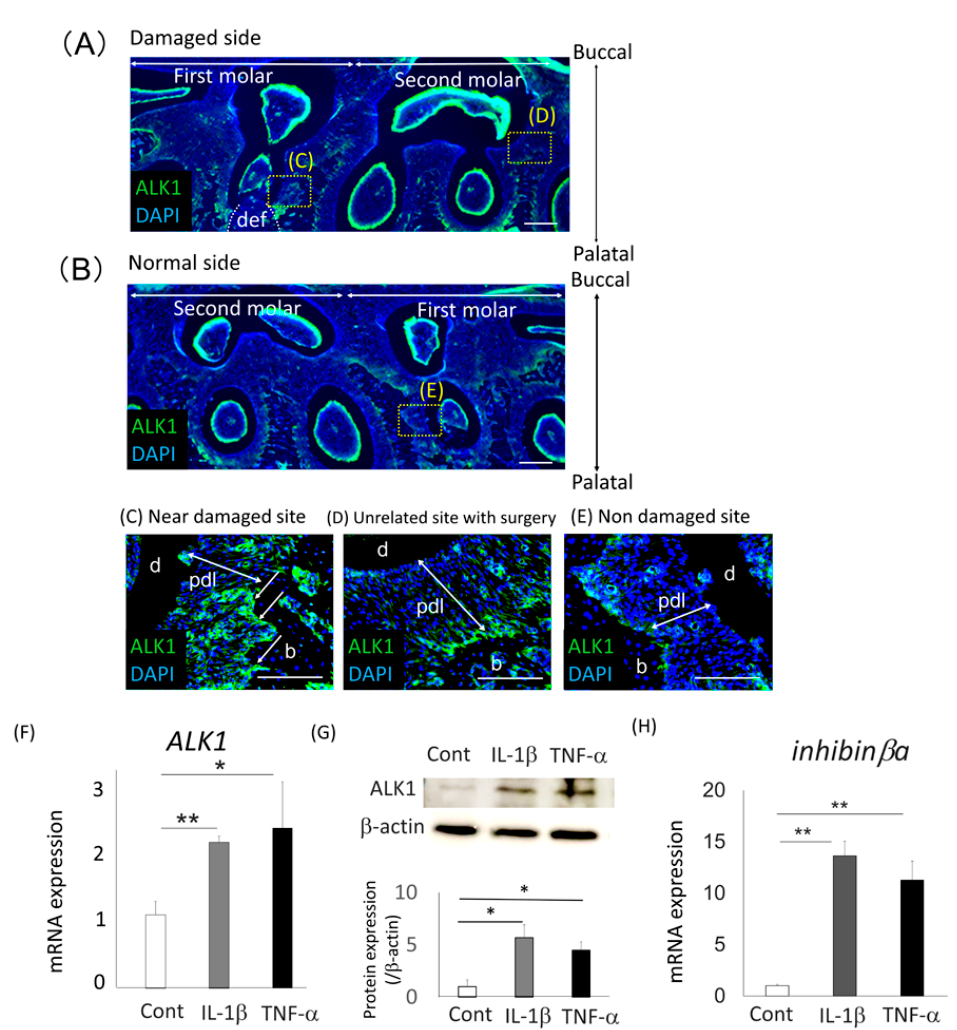
Figure 5. Expression of ALK1 around damaged rat periodontal tissue and in IL-1 β - or TNF- α -treated Saos2 cells ( A – E ) Immunofluorescent analysis of ALK1 expression (green) in a surgically damaged side ( A ) and a normal side ( B ) of rat periodontal tissue was performed. The tissue samples were collected 3 days after surgery, and horizontal sections of the first and second molars were prepared from the rat maxilla. Panels C-E show higher magnification views of panels A and B. More intense staining was detectable around the osteoblastic layer in the defect site (def) ( C ), compared with normal periodontal tissue from the second molar in the damaged site ( D ) or the first molar from the normal site ( E ) (arrows). Nuclei were stained with 4,6-diamidino-2-phenylindole (DAPI; blue). Bars = 100 µm. b, alveolar bone; d, dentin; pdl,